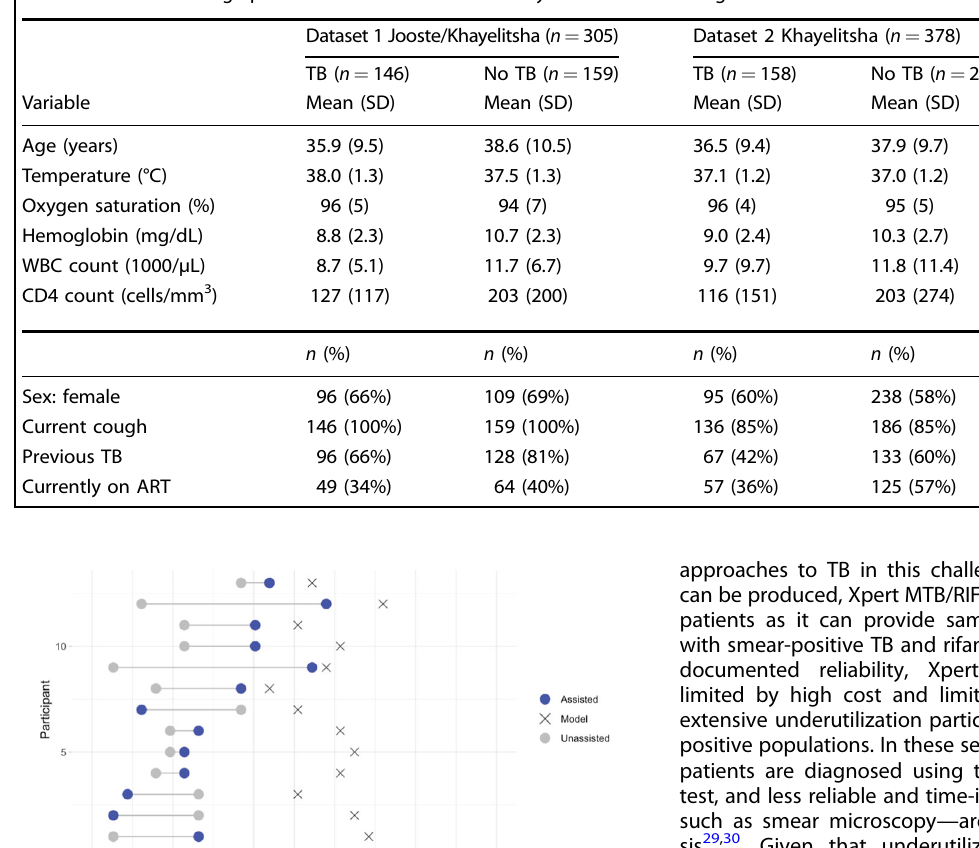
Table 1. Cohort demographic and clinical characteristics by dataset and TB